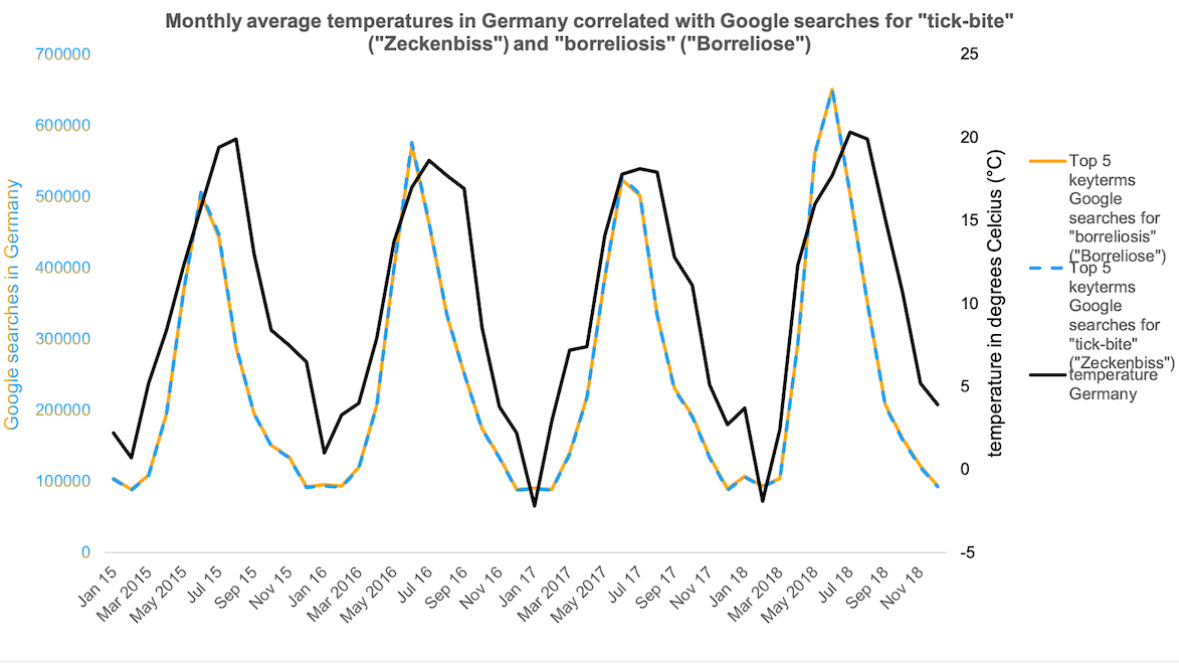
Figure 3. Google searches in Germany for "tick bite" and "borreliosis" correlated with the monthly average temperature in Germany in Celsius degrees between January 2015 to December